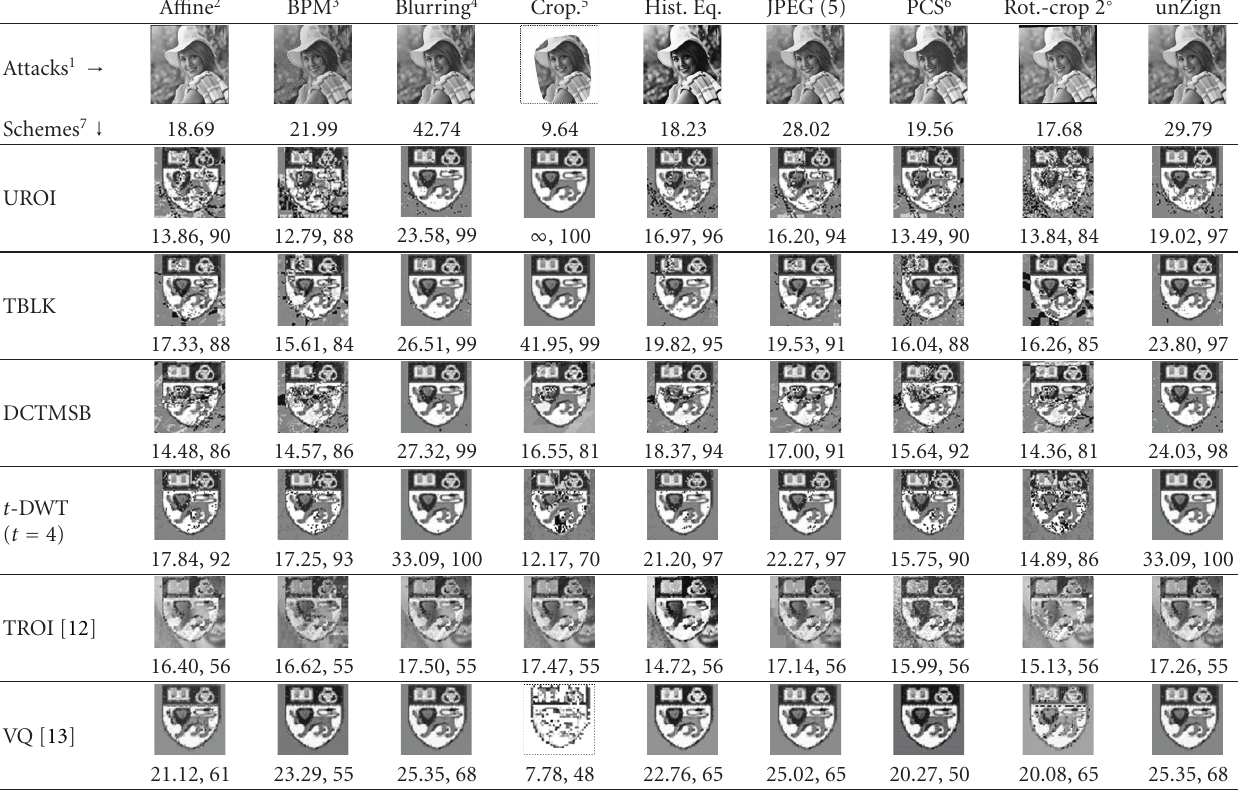
Table 6: Attacked images along with their corresponding retrieved logos using Elaine image and NUS logo by di ff erent approaches of the proposed MSB-based scheme and existing TROI-based [12] and VQ-based [13] schemes. A ffi ne 2 BPM 3